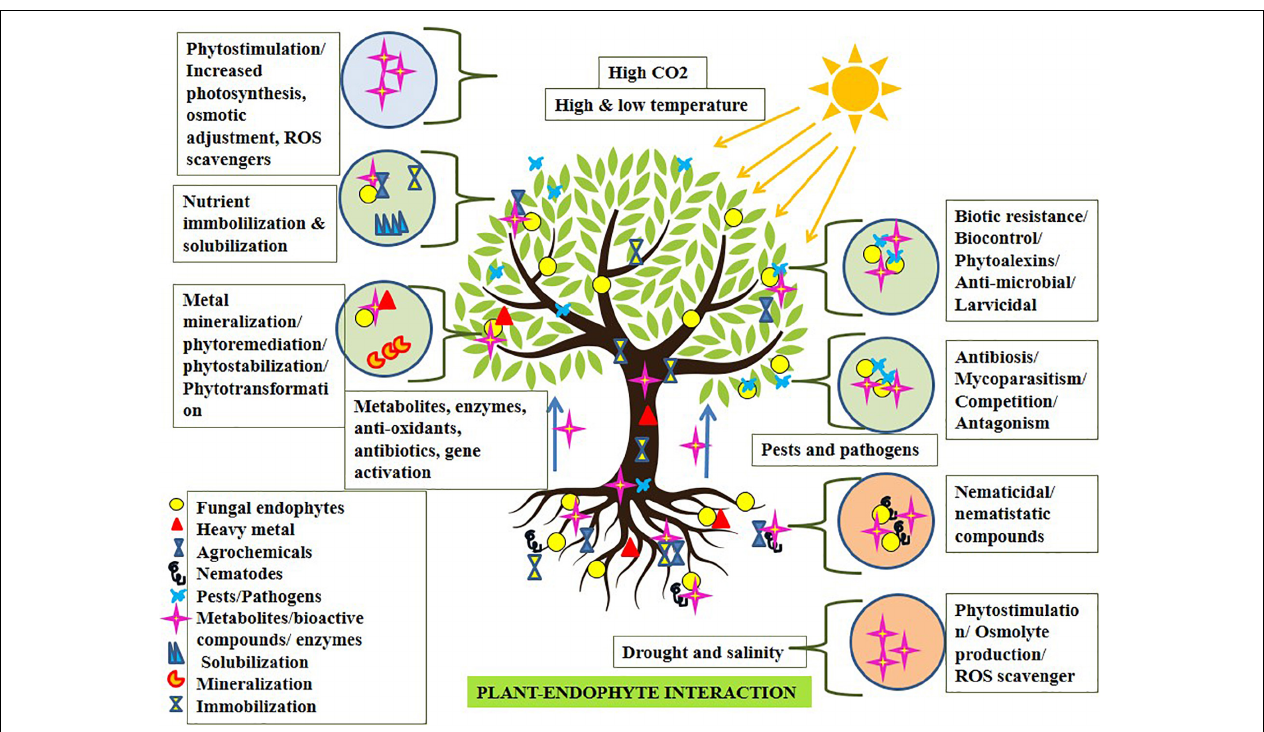
FIGURE 1 | Fungal endophyte-plant interaction expediting phytostimulation conferring stress